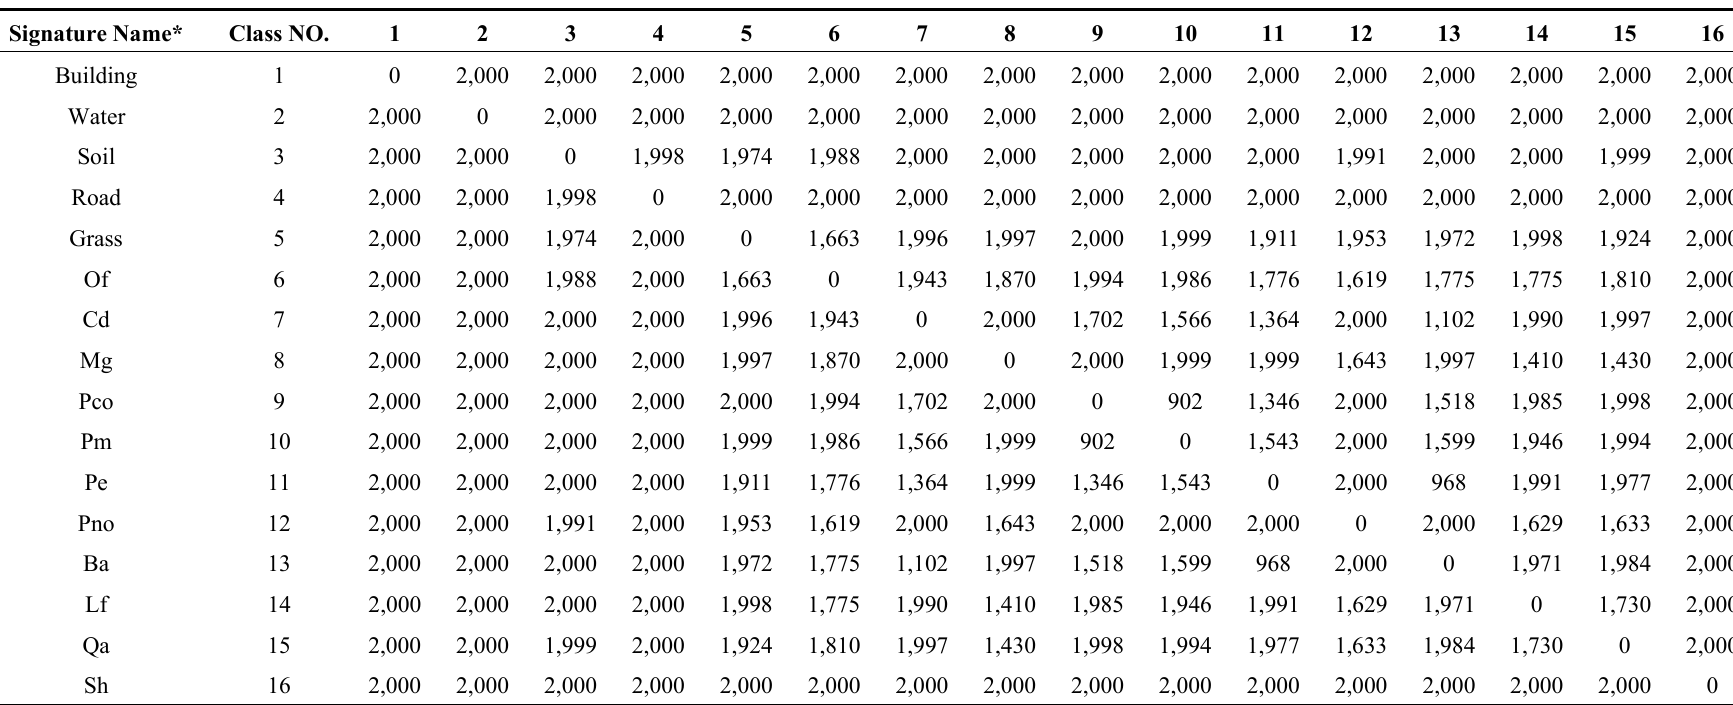
Table 3. The statistical test of the Signature Separability for the 16 classes using the Transformed Divergence